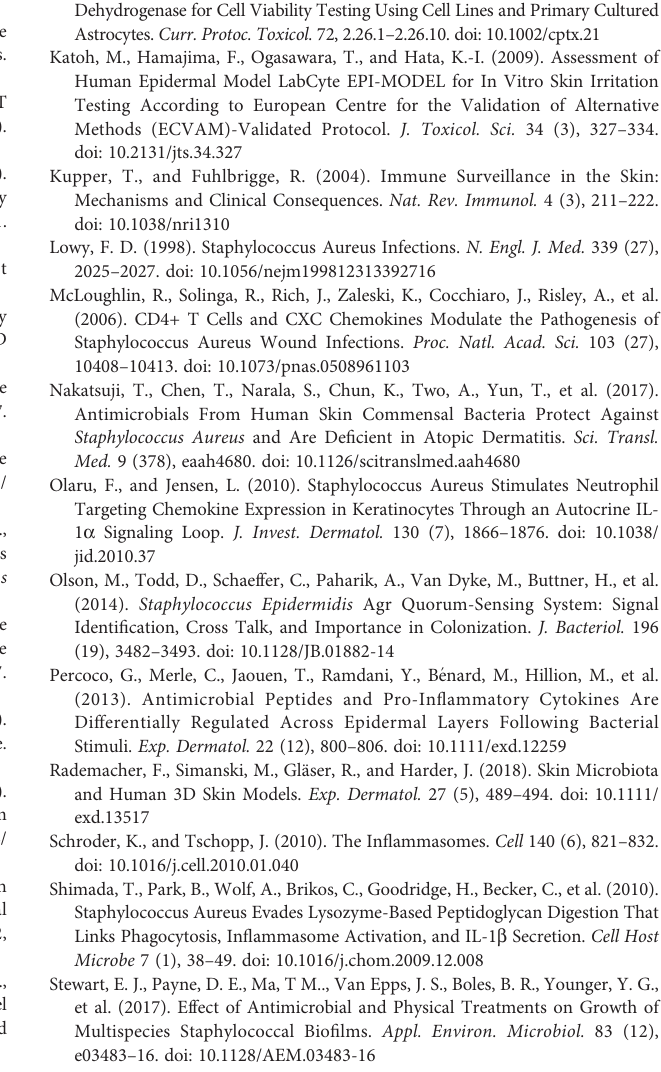
Supplementary Figure 1 | Microscopy images of claudin-1 and the epidermis colonized by S. aureus . S. aureus did not affect the expression of barrier protein claudin-1 but penetrated the epidermal tight junction. Saline, control group. SA, S. aureus was inoculated at an infective dose of 10 3 CFU/well. Bar: 10 m